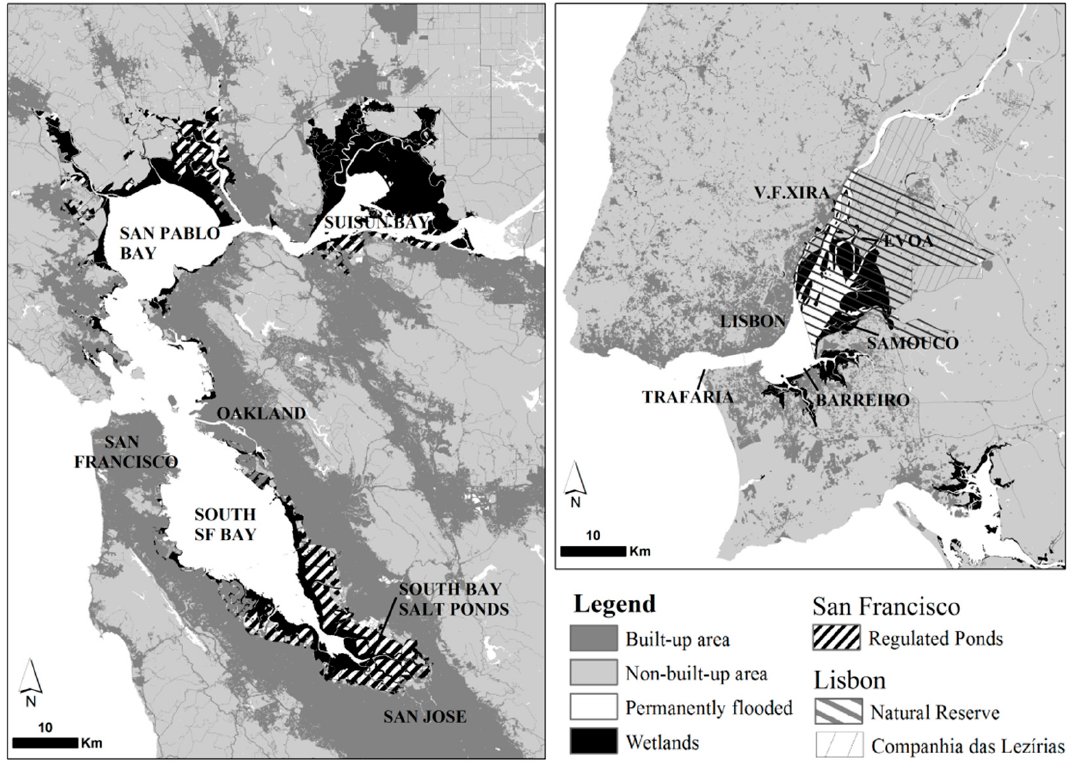
Figure 1. Side ‐ by ‐ side context maps showing both estuaries at the same scale and locations Figure 1. Side-by-side context maps showing both estuaries at the same scale and locations mentioned mentioned in the text. Situation circa 2015. in the text. Situation circa